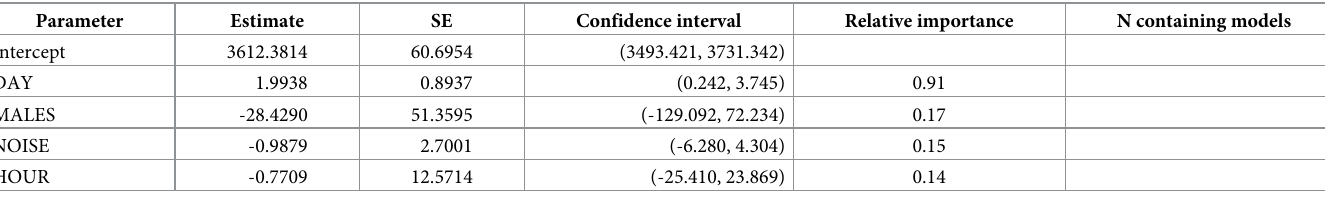
Model averaging was conducted on models with Δ AIC C < 4. Abbreviations: DAY, day of season; HOUR, hour after sunrise; NOISE, background noise level; MALES, other singing males in hearing range; NULL, null